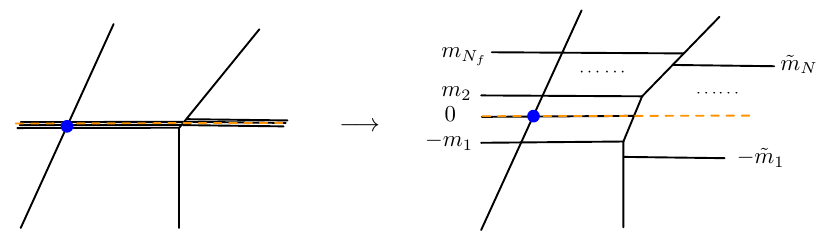
Figure 7 . In the right brane web, m i are the real mass parameters for F , and ˜ m i are real mass parameters for AF . The assignment of mass parameters are shown on the 3d brane web. m i and ˜ m j are absolute values of mass parameters, and we assume they are positive and real. The D3-brane (blue node) can locate on any fundamental D5-branes. The original line (dash orange line) is drawn along the fundamental D5-brane where the D3-brane